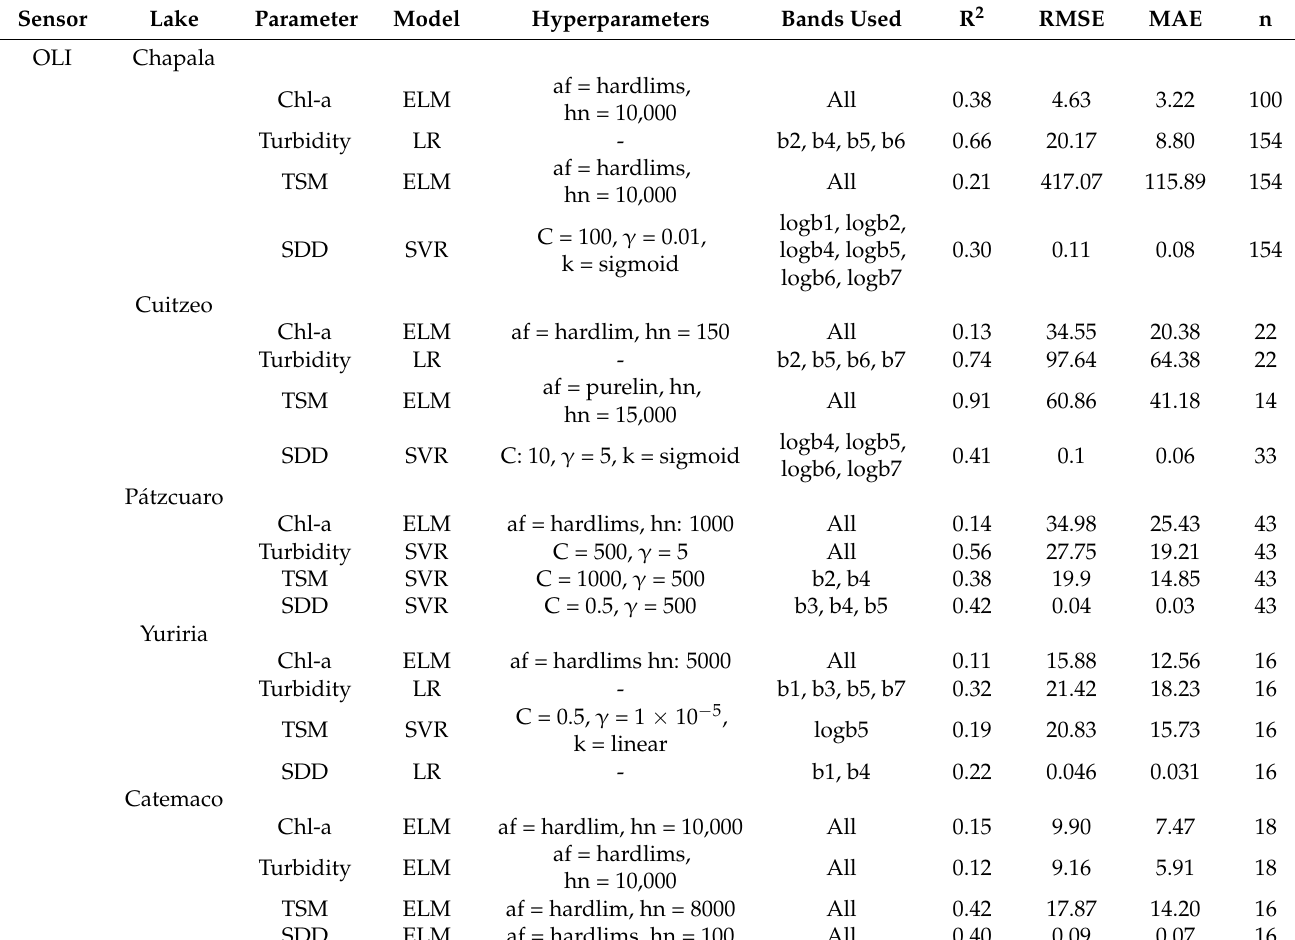
Table A4. OLI Model validation and predictive capability results for all datasets including coefficient of determination (R 2 ), root mean square error (RMSE), mean absolute error (MAE), and the number of samples (n). Sensor Lake Parameter Model Hyperparameters OLI